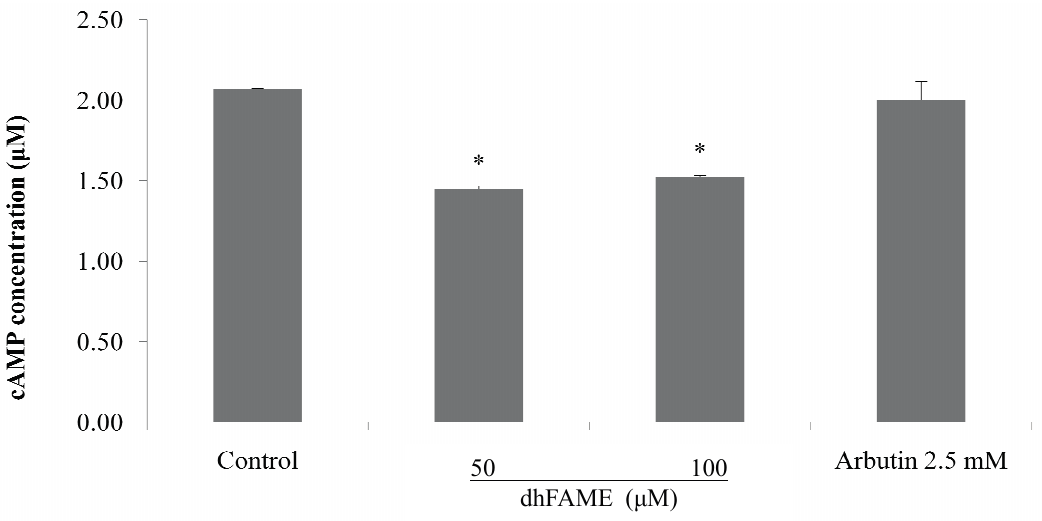
Figure 5. Effect of dhFAME on intracellular cAMP concentration in Melan-a cells. Cells (3 × 10 5 cells/well) were cultured for 24 h and the medium was replaced with fresh medium containing various concentrations of dhFAME and arbutin for 12 h. Intracellular cAMP levels were measured using a cAMP direct immunoassay kit. Each determination was made in triplicate and the data shown represent the mean ± SD. Data was considered to indicate statistical significance (* p < 0.05) by means of the student t -test.